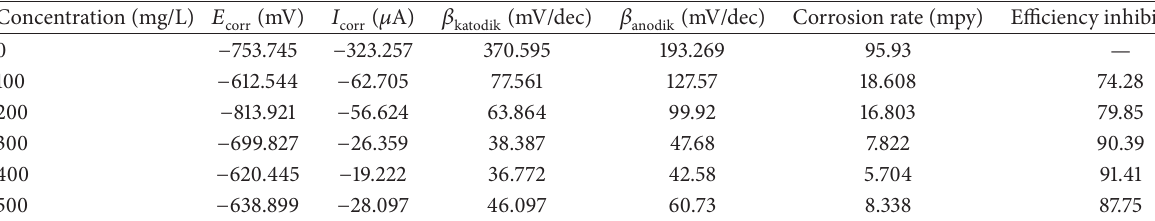
Table 1: The corrosion parameters obtained from polarization plots.